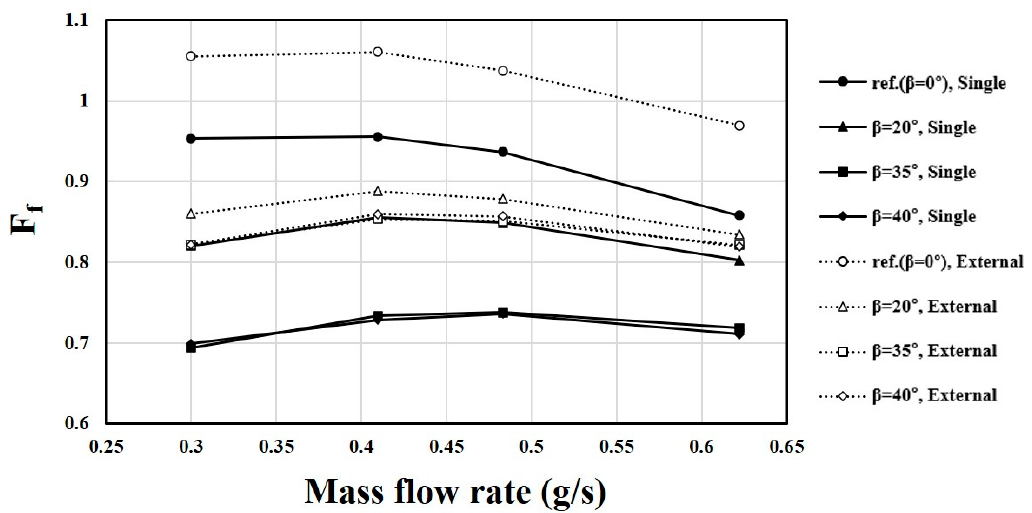
Figure 15. Comparison of F f variation with mass flow rate between the cases with and without external flow for various bending angles.